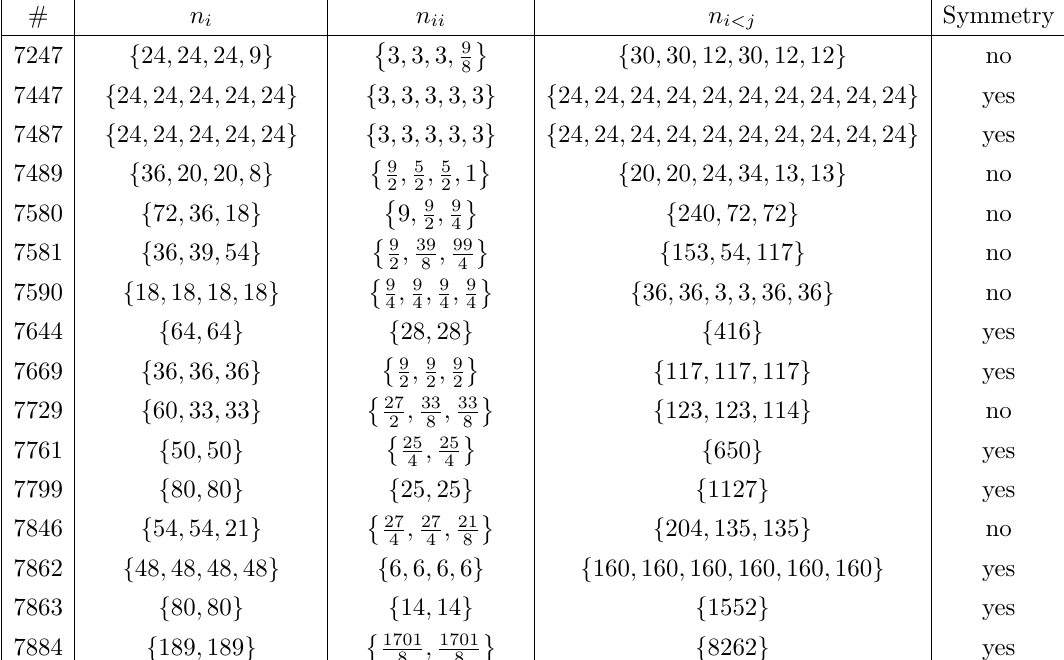
yes also de- i ’s i and n . ii ij